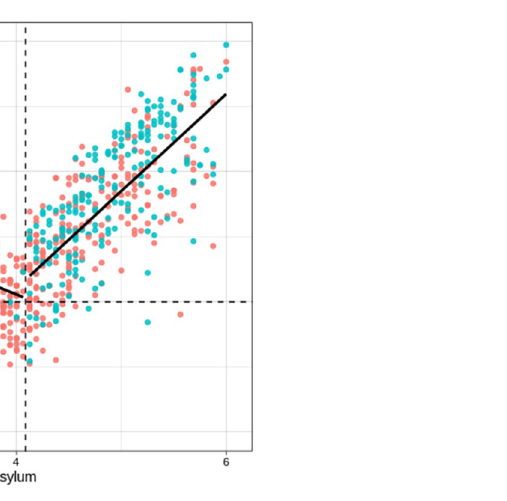
respectively, and is marked by the vertical dashed line. The horizontal dashed line corresponds to a truly false consensus score of zero. Continuous lines indicate linear regression lines.